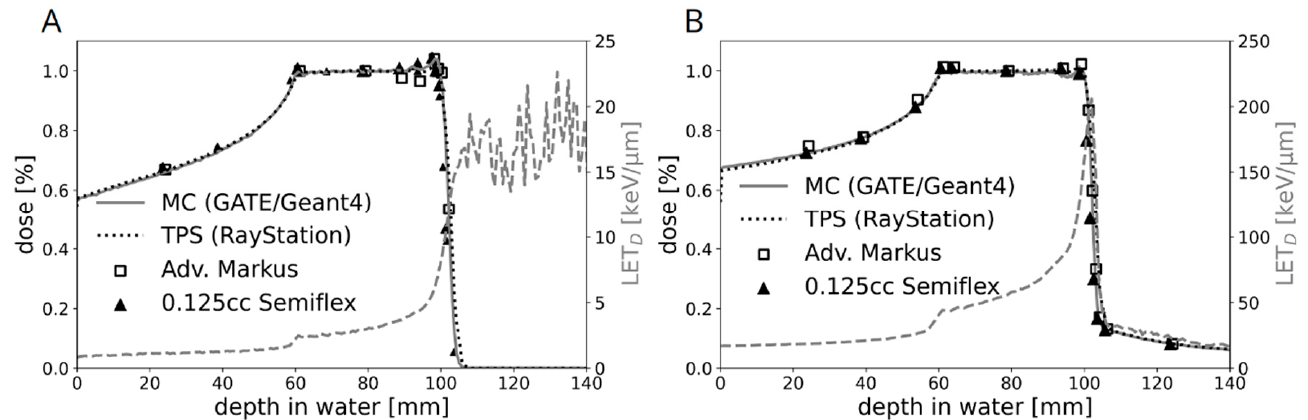
Figure 2. The percentage depth dose curves of the ( A ) proton and ( B ) C-ion SOBP used for cell irradiations. A very good agreement between the predicted dose distributions of the treatment planning system (TPS) and Monte Carlo (MC) simulation was achieved. The respective LET spectrum shows the increase with increasing depth in water. C-ions have a much higher LET than protons, which is reflected by the scale of the mirrored y-axis (25 keV/ µ m versus 250 keV/ µ m). For protons, the LET after the fall-off region has no physical meaning as no particles are delivered beyond this depth.